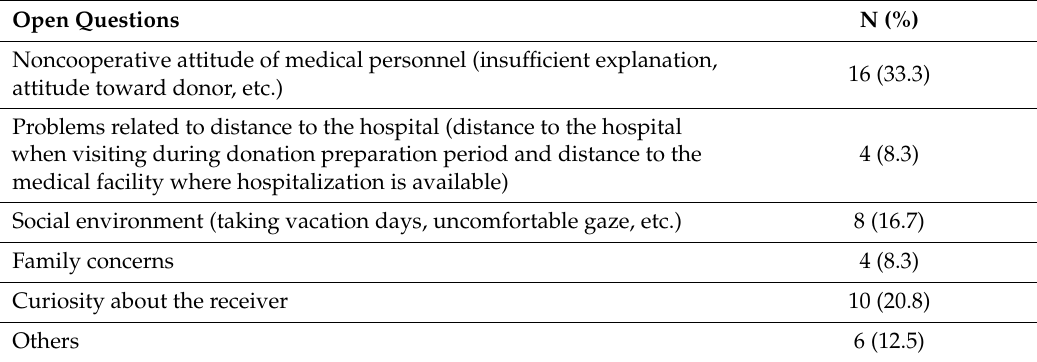
Table 5. Other discomfort during HSCD process (N =